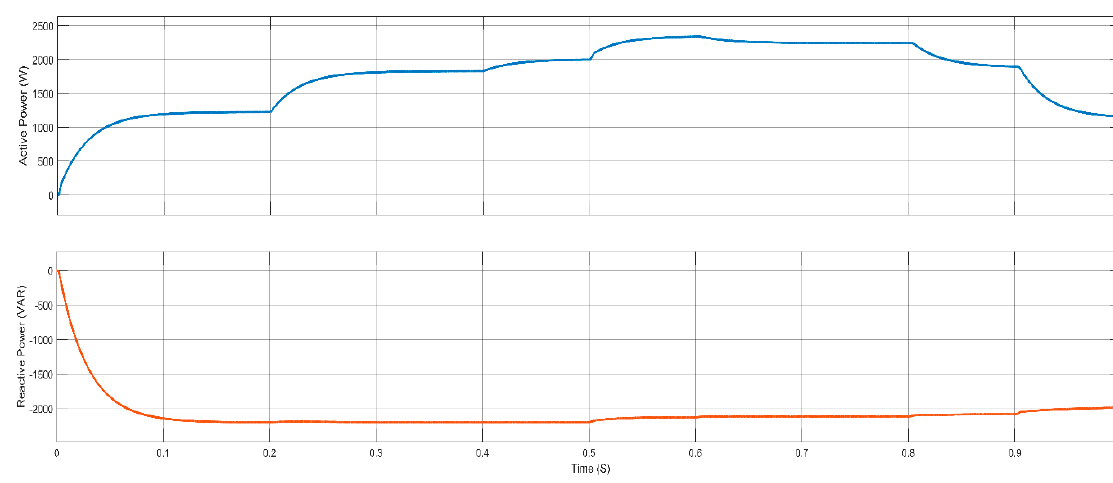
Figure 14. Active and Reactive Power.